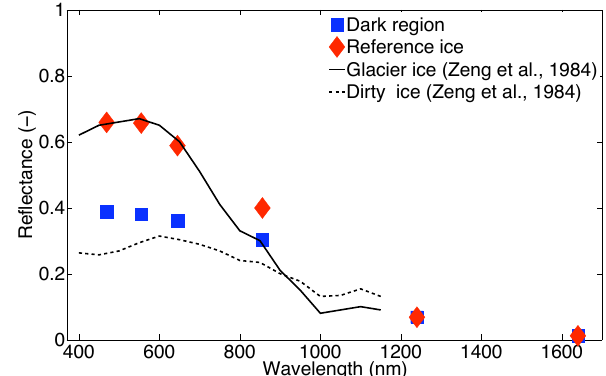
Fig. 5. Radiances for the dark region and for reference ice, as a function of wavelength, for 9 August 2007.